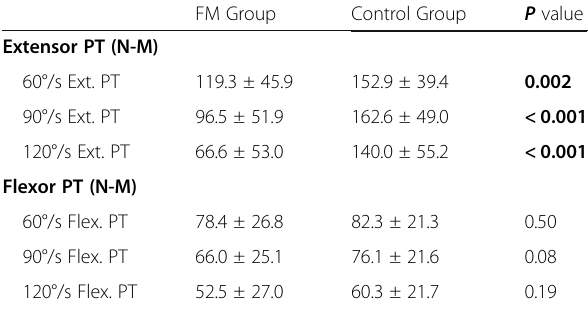
Table 2 The results of isokinetic measurements of the groups FM Group Control Group